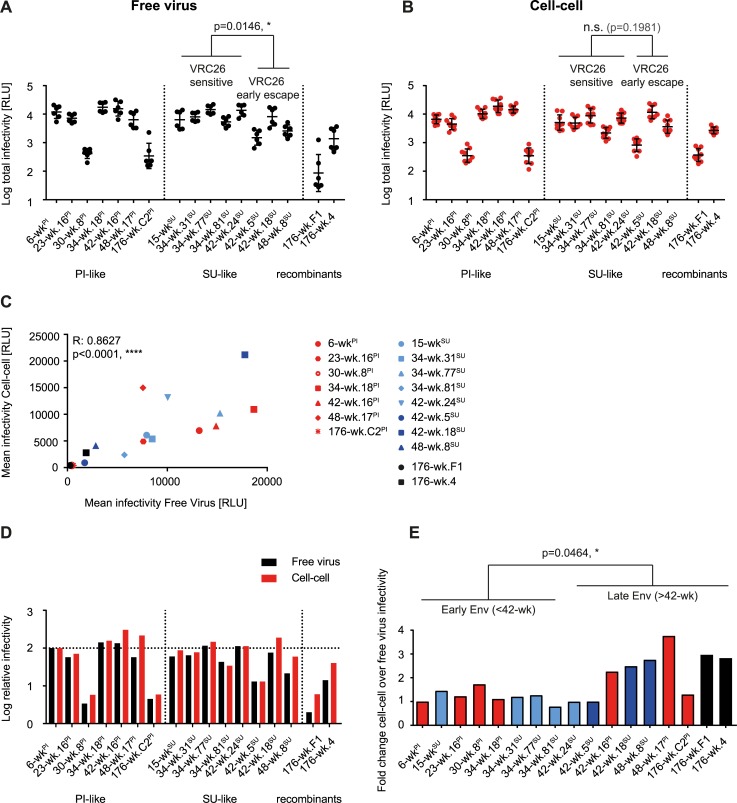
Early VRC26 escape results in virus variants with reduced entry fitness.A and B: Replicative capacity for CAP256 Env reporter pseudoviruses was tested by infecting A3.01-CCR5 cells either with free virus preparations (A) or transfected 293-T cells to probe cell-cell transmission (B). Infectivity for free virus (A, black) and cell-cell transmission (B, red) is displayed in relative light units (RLU). Means of two (free virus) to three (cell-cell) independent experiments in duplicates with SD are shown. SU-like VRC26 sensitive viruses were compared to SU-like VRC26 early escape viruses using the Mann-Whitney test. P values are indicated. C: Correlation between free virus and cell-cell infectivity were determined by Spearman correlation on untransformed data sets. R and p values are indicated. PI-like, SU-like VRC26 sensitive, SU-like VRC26 early escape and PI/SU recombinant viruses are marked in red, light blue, dark blue and black respectively. D: Results of the free virus (black) and cell-cell (red) infectivity assay were normalized to the PI-virus, 6-wkPI, and are indicated as relative infectivity. Relative means are shown. E: The ratios of relative infectivity values for cell-cell and free virus transmission are depicted. Early viruses (wk 6 to wk 34) were compared to late viruses (wk 42 to wk 176) using the Mann-Whitney test. The P value is indicated. PI-like, SU-like VRC26 sensitive, SU-like VRC26 early escape and PI/SU recombinant viruses are marked in red, light blue, dark blue and black respectively.